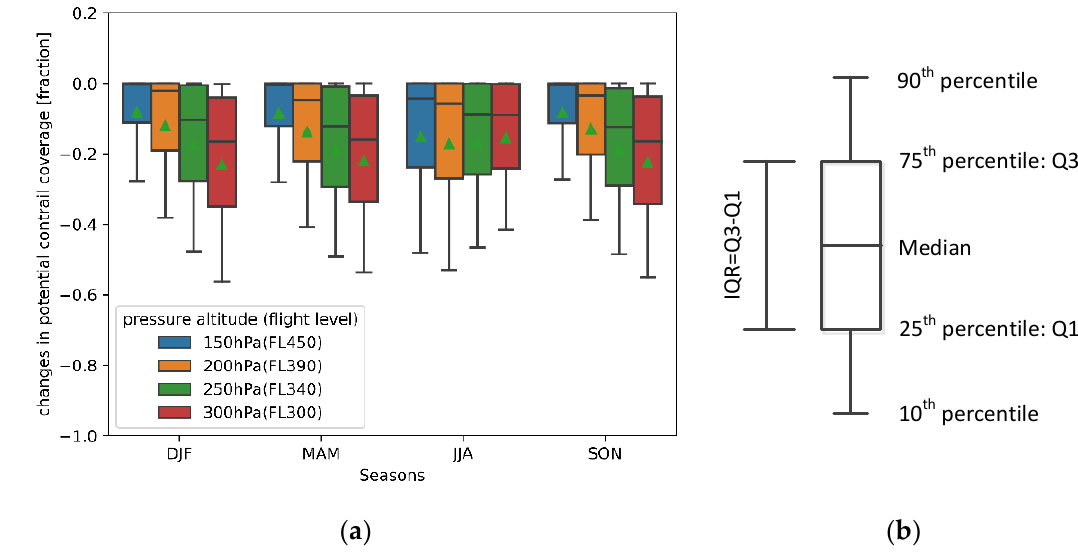
Figure 13. Seasonal effects on the changes of potential contrail coverage at various pressure altitudes for 90% electric hybridization ( a ) and the explanation of the boxplot ( b ). DJF: December, January, and February; MAM: March, April, and May; JJA: June, July, and August; SON: September, October, and November. For the boxplot: the 10th and 90th percentiles of the data are plotted. Triangle indicates the mean value. As the altitude increases, e.g., at 150 hPa (FL450), the values at 90th percentile and 75th percentile are equal to the minimum of the datasets as zero, therefore not visible in Figure ( a ).